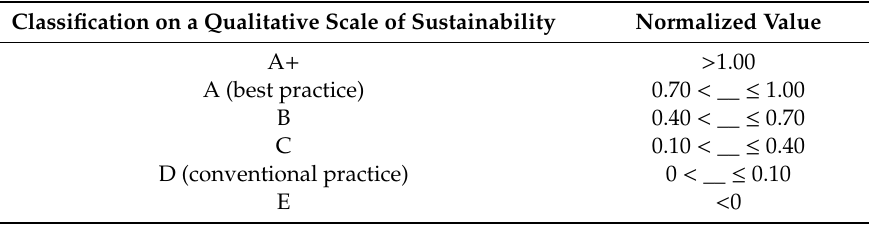
Table 2. Sustainability levels—SBTool Urban.